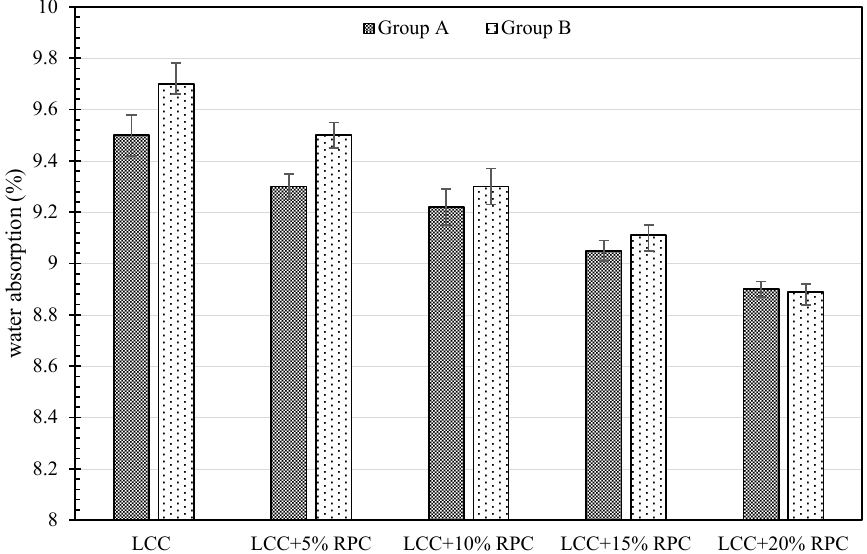
Figure 4. Water absorption rate of two groups of concretes containing various amounts of RPC.